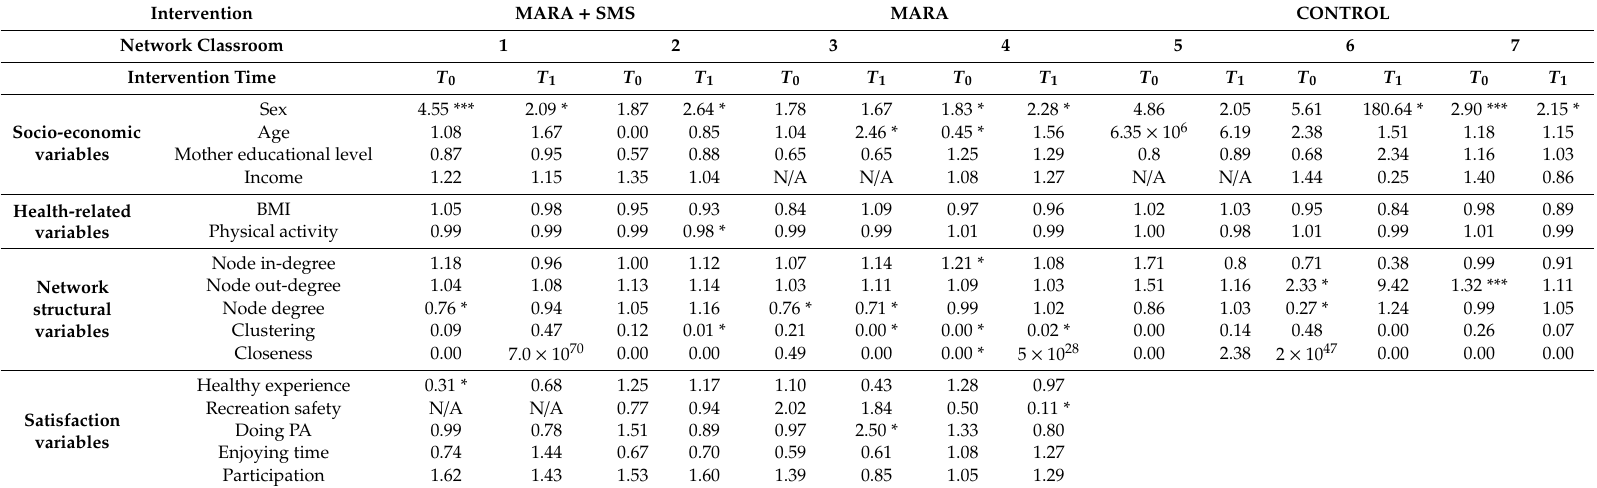
Table A3. Odds ratios of variables in the formation of friendship ties for two time-points in the three di ff erent schools of the study. Measures are explained in the Methods